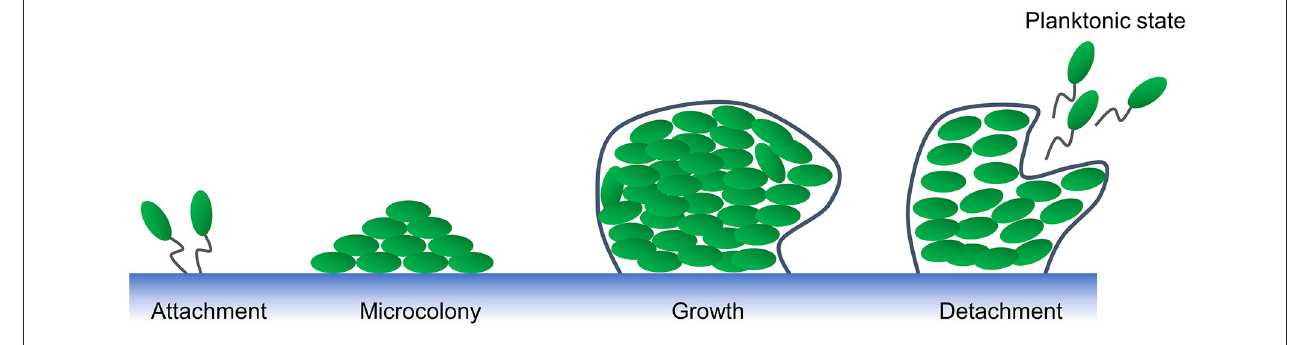
FIGURE 2 | Biofilm